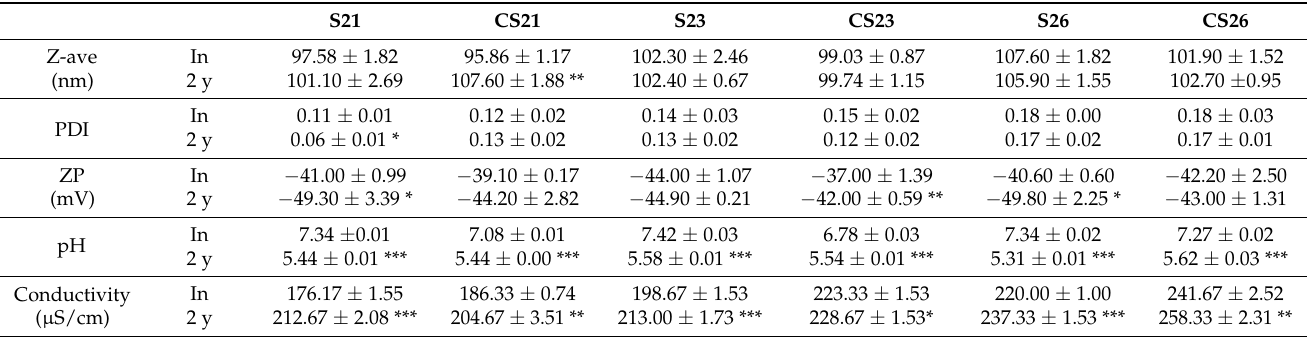
Table 5. Physicochemical parameters for soybean oil nanoemulsions containing PEG2000-DSPE measured initially (In) and after two years of storage at room temperature (2 y).